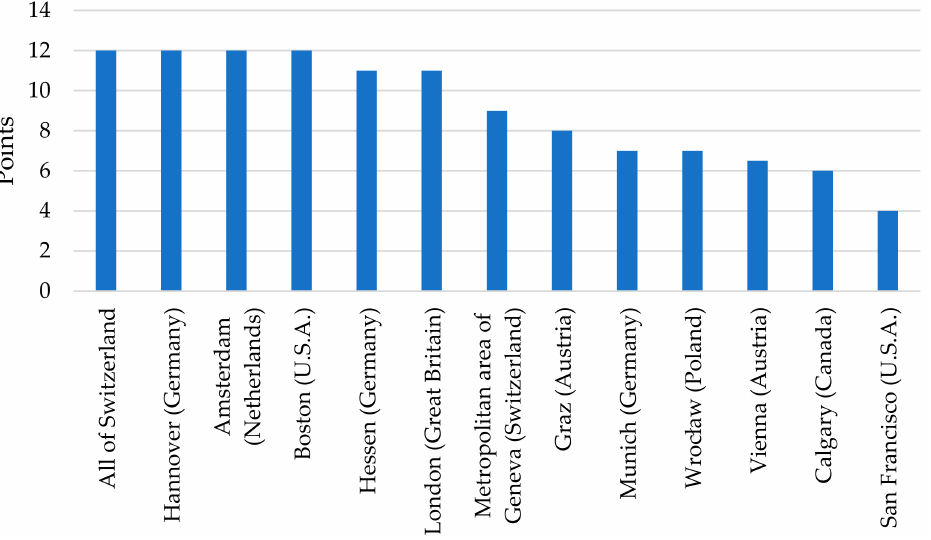
Figure 16. Ranking of evaluated solar cadastres. Source: own